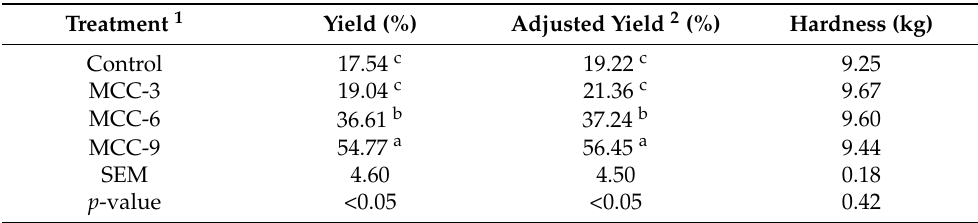
Table 4. Mean (n = 3) yield (%), adjusted yield (%), and hardness (kg) values of Feta-type cheese made from micellar casein concentrate